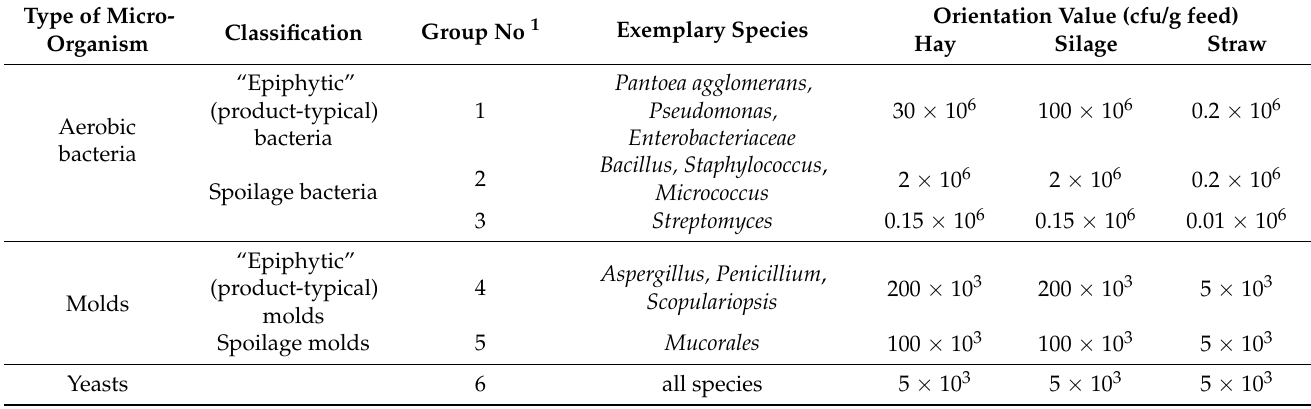
Table 3. Orientation values for germ counts of hay, silage, and straw according to VDLUFA